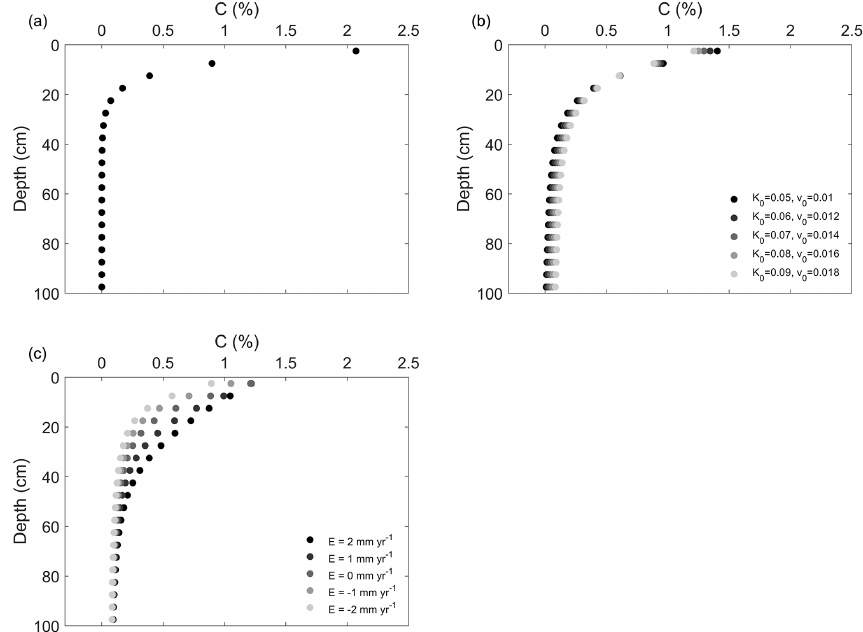
Figure 3. The simulated C content profiles in (a) Scenario 1, (b) Scenario 2 and (c) Scenario 3. See Sect. 2.2.7 and Table 2 for descriptions of the scenarios. In (b) , K 0 (myr − 1 ) is the diffusion coefficient at the topsoil layer and v 0 (myr − 1 ) is the advection term at the topsoil layer (Eq. 18). In (c) , E indicates the soil redistribution rates, with negative values indicating erosion and positive values indicating deposition. K 0 and v 0 were set to be 0.09myr − 1 and 0.018myr − 1 , respectively. In (b) and (c) , both K d and v d (depth attenuation of diffusion and advection) were set to be 0.01m − 1 .